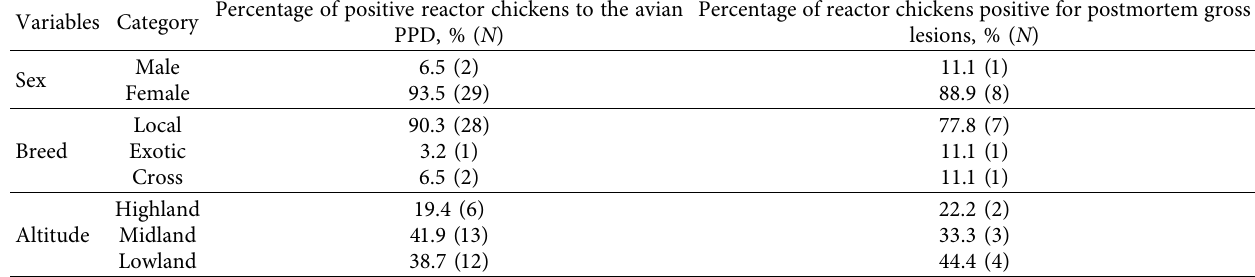
Table 3: Postmortem gross pathological lesions in positive chickens with their breed, sex, and origin. Percentage of positive reactor chickens to the avian Variables Category PPD, % ( N )